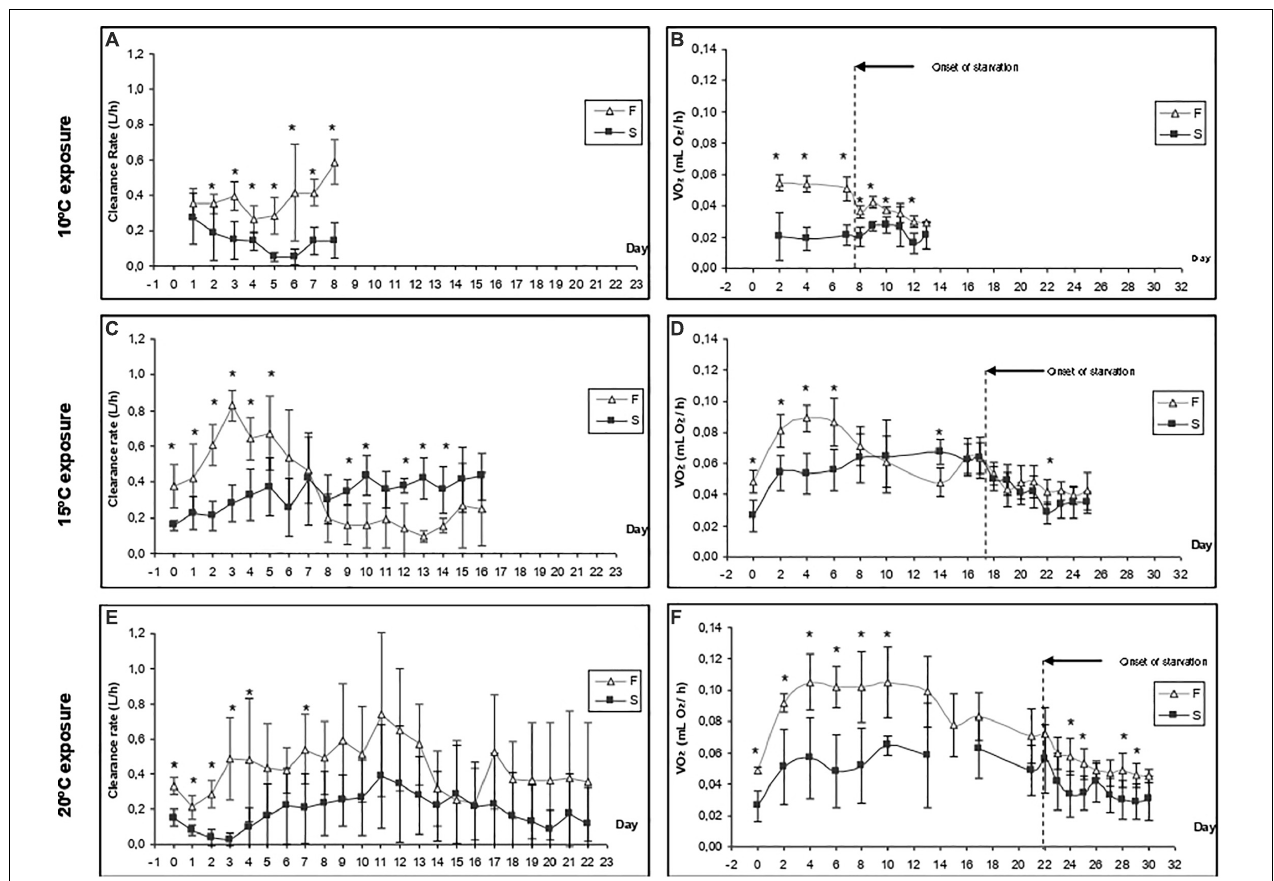
FIGURE 3 | Time-course of the clearance rate (A,C,E) and oxygen consumption (B,D,F) of F 10 and S 10 mussels at three exposure temperatures (20, 15, and 10 ◦ C). Five individuals from each group were monitored in each experimental condition. Asterisks indicate significant differences between fast- and slow-growing individuals (ANOVA, p <